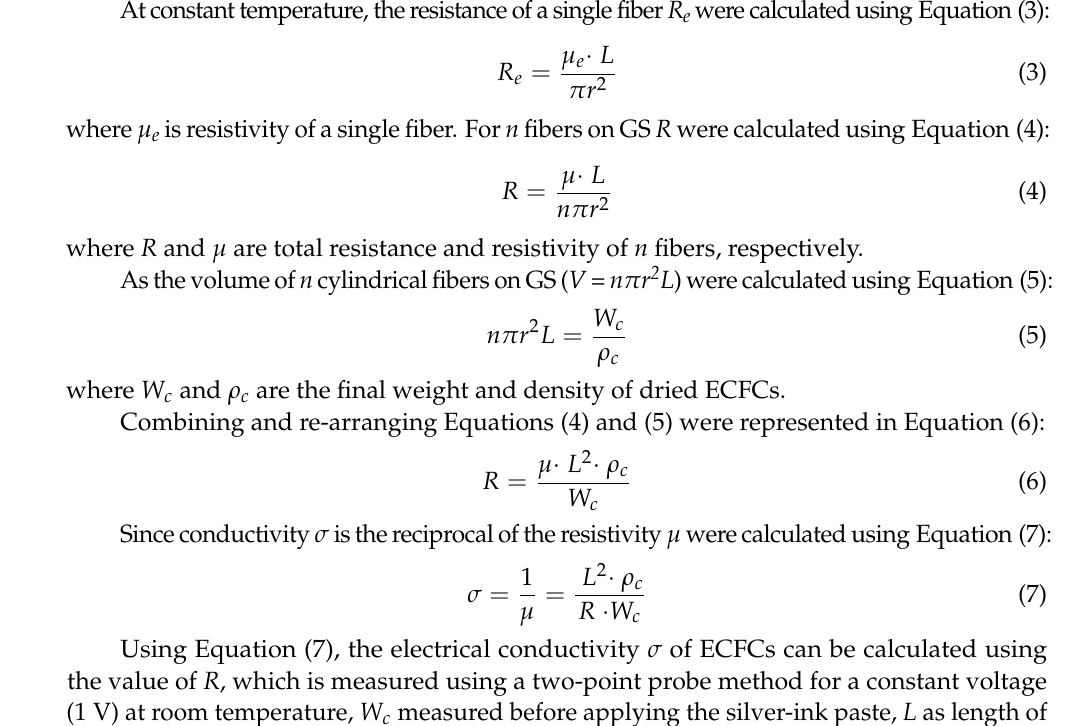
Figure 14. The schematic of a single fiber (length L and radius r ) with n number of fibers and a single bundle of n fibers for derivation of equations of electrical conductivity ( σ ) and elastic Young’s modulus ( E ) of ECFCs, respectively.